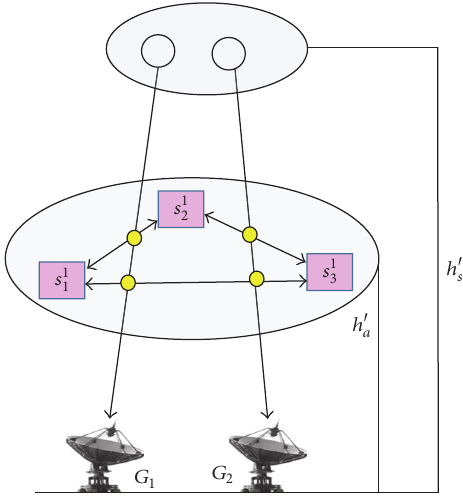
Figure 1: Interference between ISLs and